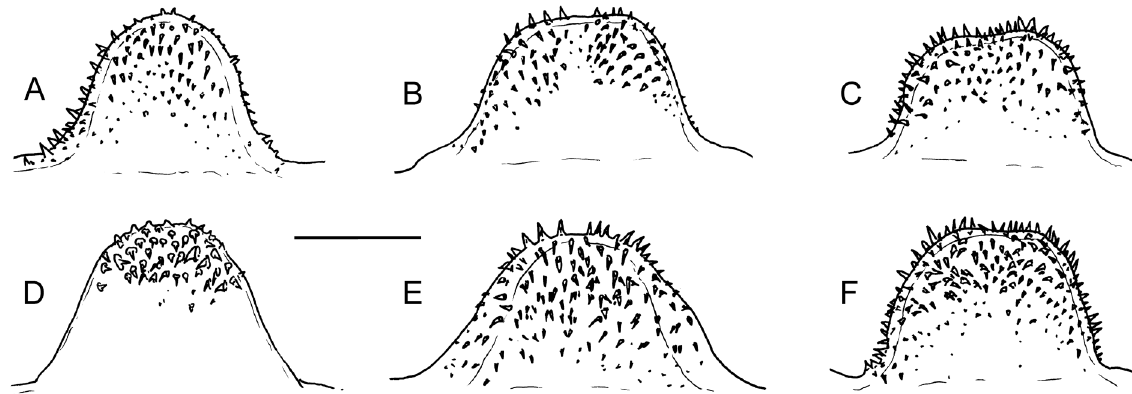
Fig. 3. Transtilla of Phtheochroa spp. A–B . P. schawerdae (Rebel, 1908) comb. nov., Bulgaria, Rila